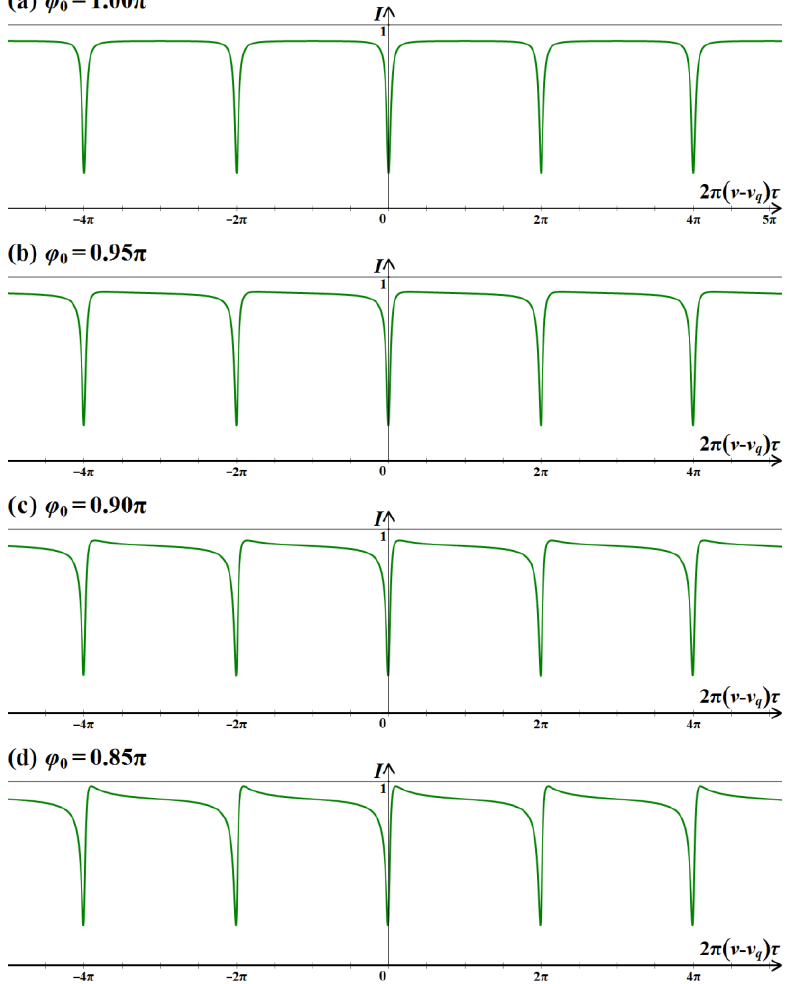
Figure 3. Simulated resonant curve of φ 0 = ( a ) 1.00 π, ( b ) 0.95π, ( c ) 0.90π, and ( d ) 0.85π.